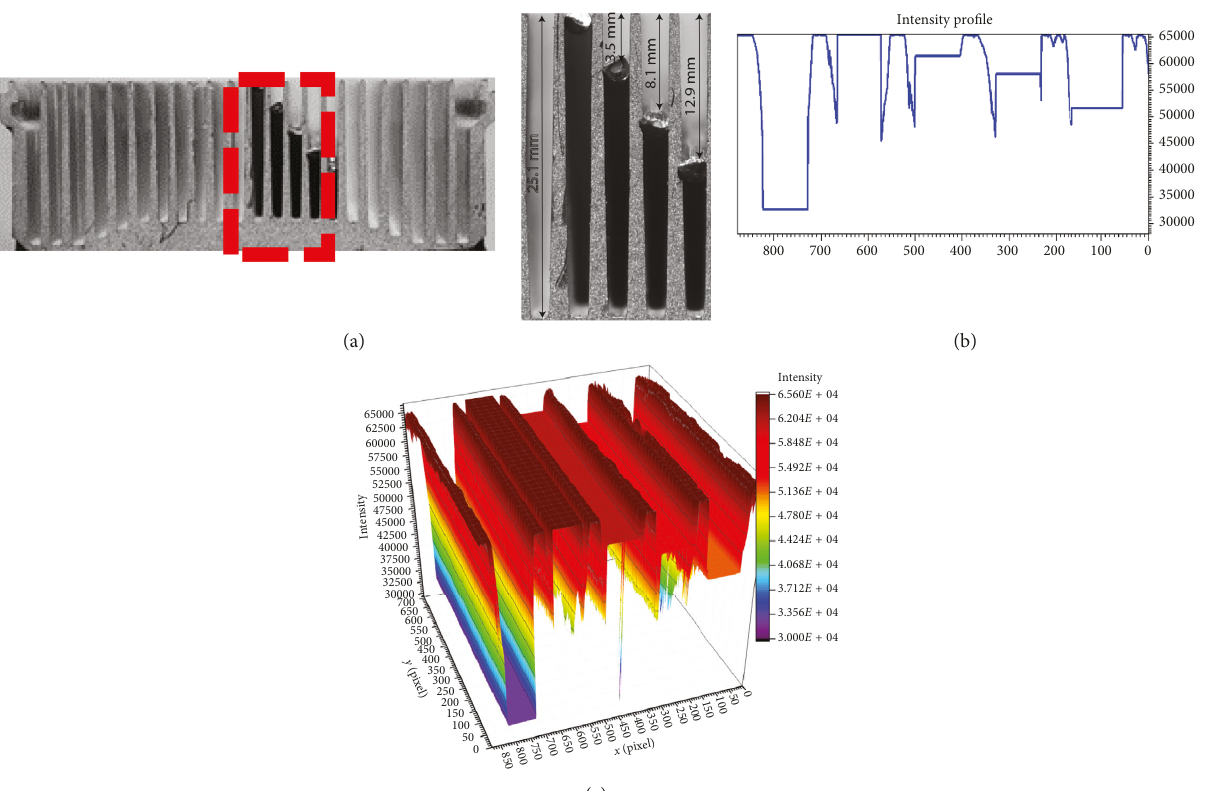
Figure 4: A heat dissipater and the pixel intensity distribution: (a) heat dissipater, (b) 2D pixel intensity distribution in averaged gray level, and (c) 3D pixel intensity